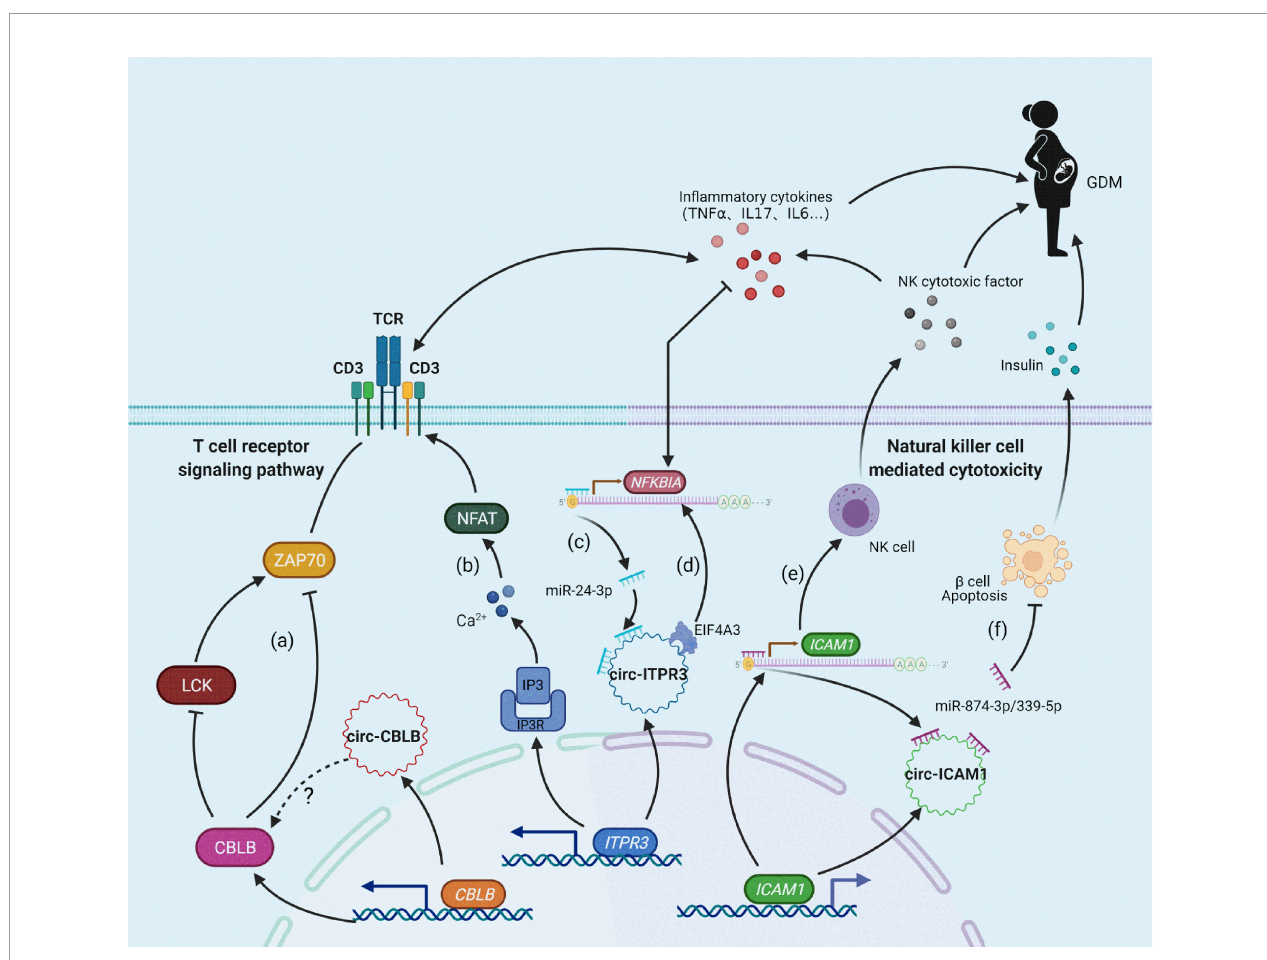
FIGURE 4 | Molecular mechanism of the relationship between candidate circRNAs/mRNAs and GDM. (A) CBLB can inhibit LCK and ZAP70 expression levels by ubiquitination, thus exerting negative feedback regulation on T-cell receptor activation; (B) ITPR3 can encode IP3R in response to IP3-mediated Ca2 + release and promote the activation of the T cell receptor signaling pathway; (C, E) circ-ITPR3 and circ-ICAM1 act as miRNA sponges for miR-24-3p and miR-874-3p/miR-339- 5p, respectively, which induces upregulation of the downstream target genes NFKBIA and ICAM1; (D) circ-ITPR3 regulates the expression of NFKBIA by recruiting EIF4A3. (F) The adsorption of circ-ICAM1 to miR-874-3p weakens the anti-apoptotic effect of miR-874-3p, which increases the apoptosis of b cells and decreases the release of